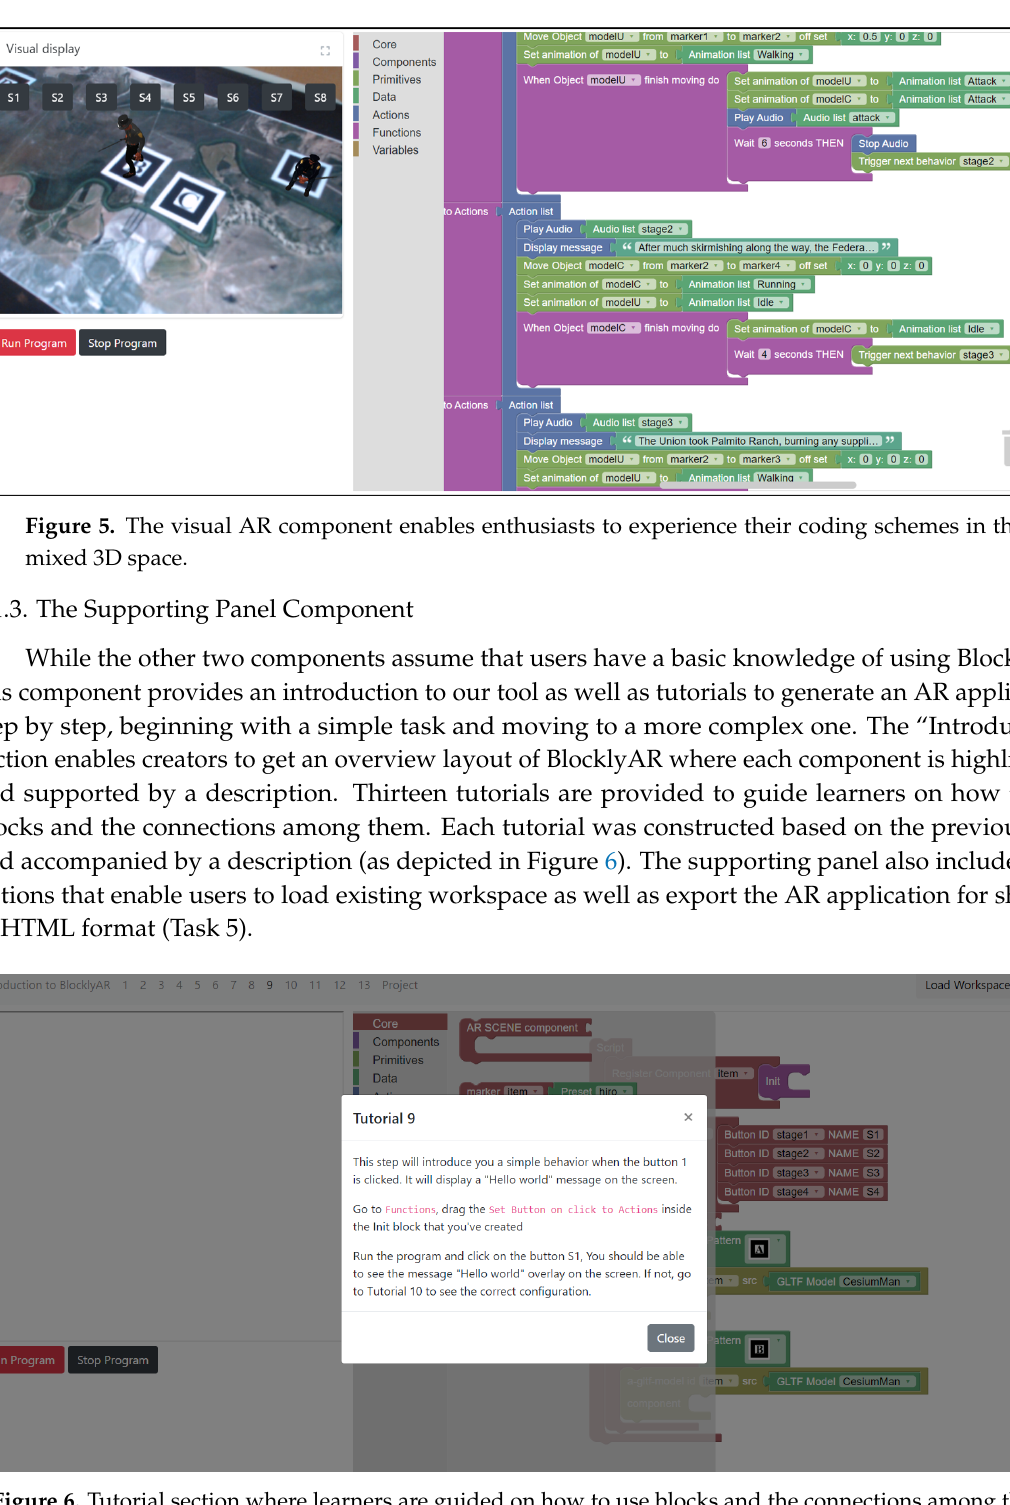
Figure 6. Tutorial section where learners are guided on how to use blocks and the connections among